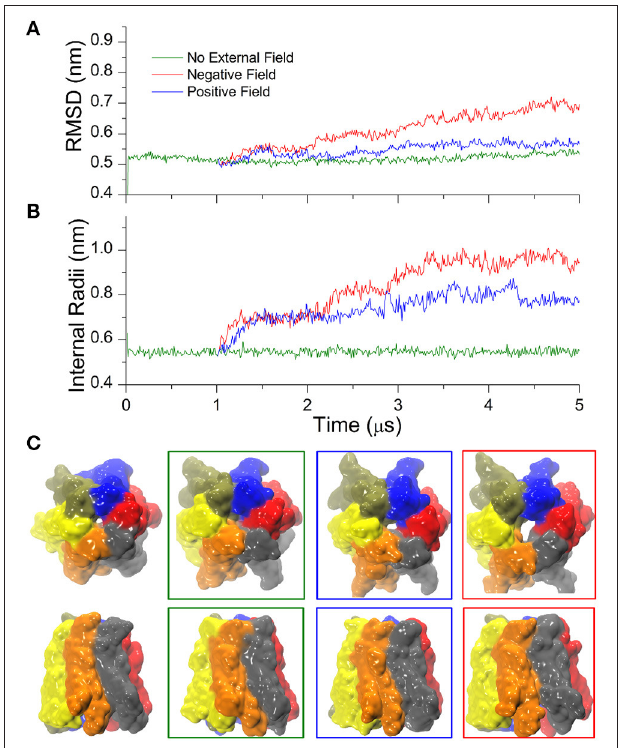
FIGURE 4 | Calcium bound Cx26 under external electric field. (A) RMSD on the Cx26 Connexon in absence (green) and presence of an external field (red: negative or polarizing; blue: positive or depolarizing). The external field in either direction was applied after 1 µ s of simulation in the absence of an external field. (B) Internal radii as a function of the simulation time in the absence and in the presence of external field measured at the level of Lys41. (C) Solvent accessible surfaces of Cx26 conformers at different point of the simulations. From left to right: initial, after 1 µ s in absence of external field, after 4 µ s under depolarizing field, and after 4 µ s of polarizing field. The apparent differences in the external diameter are originated by the flexible C-terminal